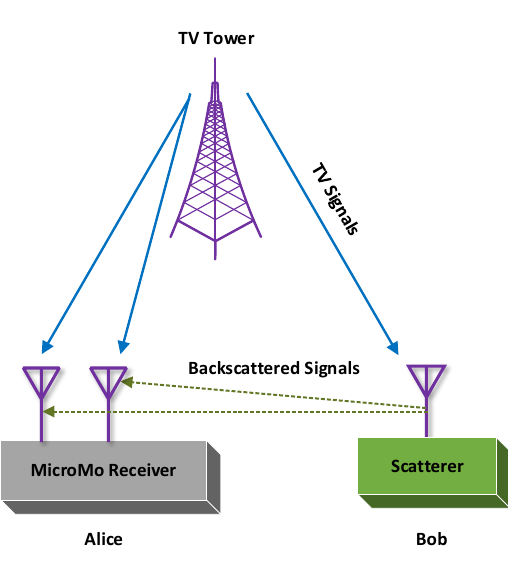
Figure 14. µ mo decoding in BackCom.